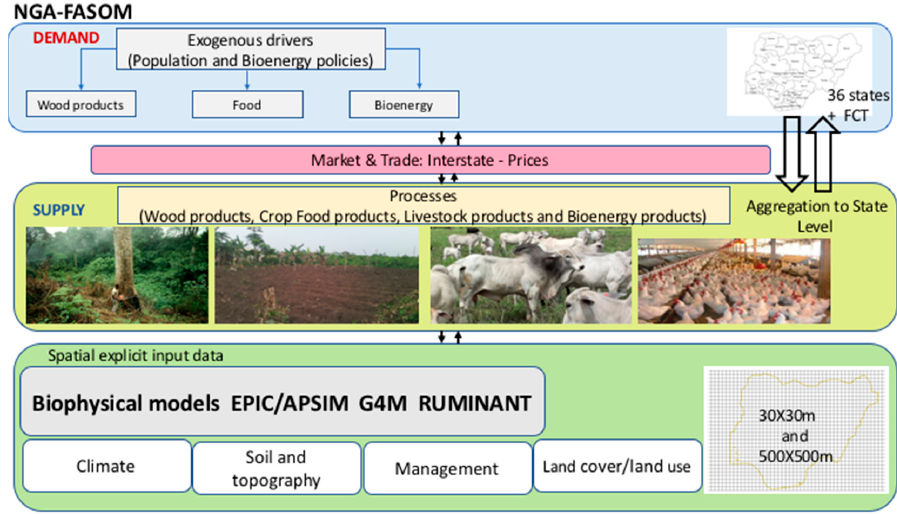
Figure 1. Structure of the Nigeria Forest and Agricultural Sector Model (NGA–FASOM).